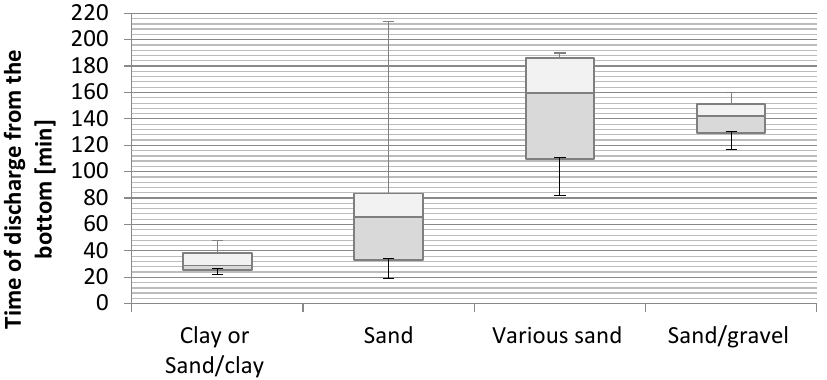
Figure 7. Time of the drilling fluid outflow from the bottom for specific fractions.